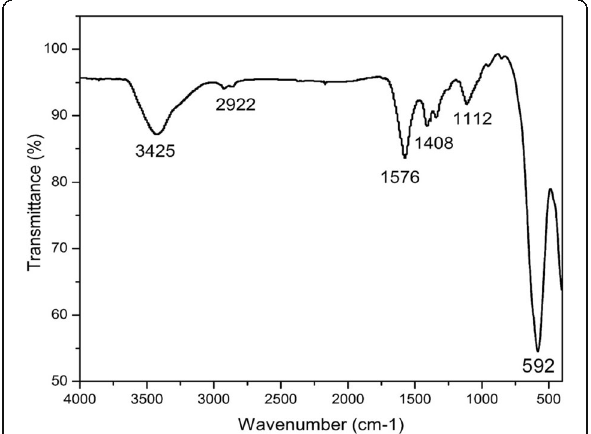
Fig. 3 Fourier transform infrared spectroscopy (FTIR) employed in the range 500 – 4000 cm − 1 to investigate the structural properties of the samples. The data confirms the PEG-coated cobalt ferrite nanoparticles